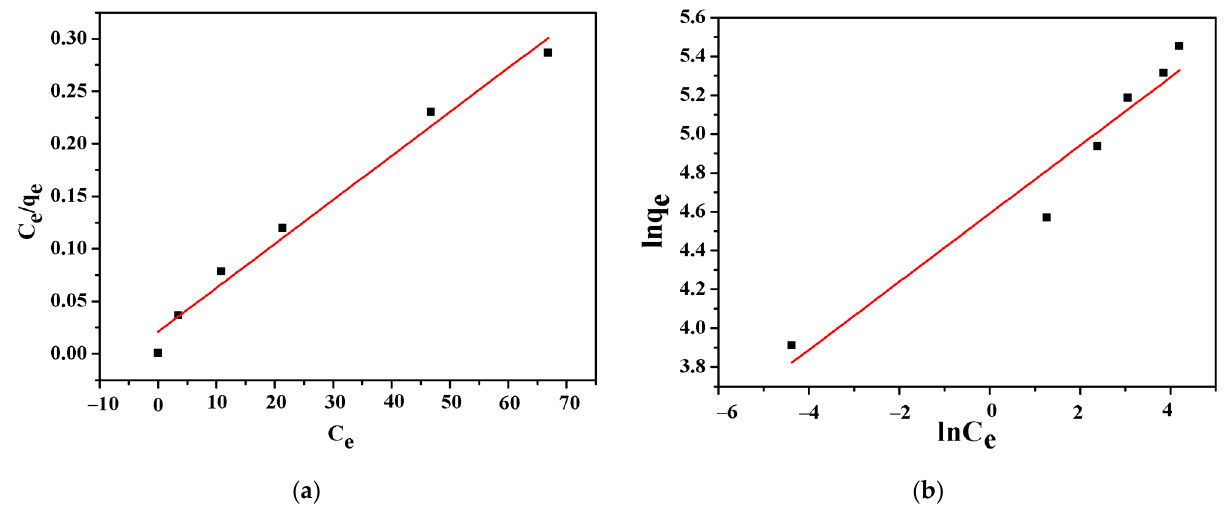
Figure 5. Fitting curves of ( a ) Langmuir and ( b ) Freundlich isotherm models for adsorption of Pb(II) on CSH . Table 2. Fitting parameters of Langmuir and Freundlich adsorption models for adsorption of Pb(II) on CSH . Langmuir Parameter Freundlich Parameter